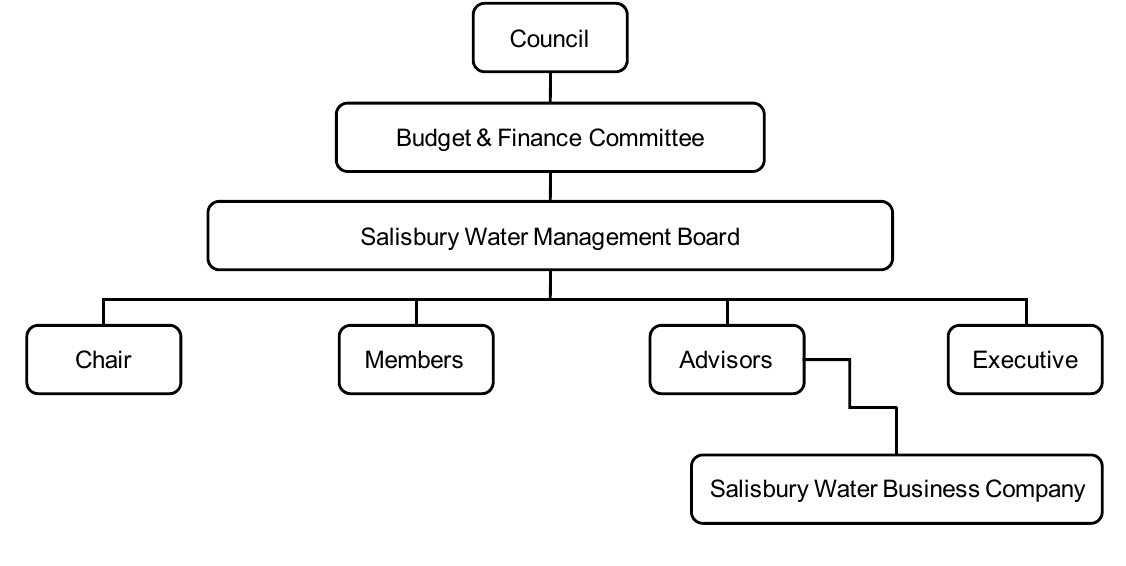
Figure 2. Governance Structure of Stormwater Project in Salisbury Local Government Area